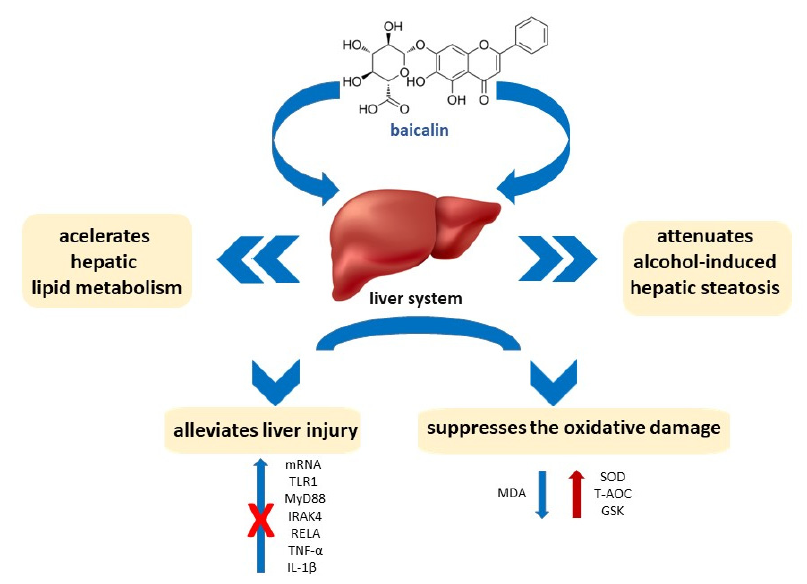
Figure 4. The effects of baicalin on the liver.